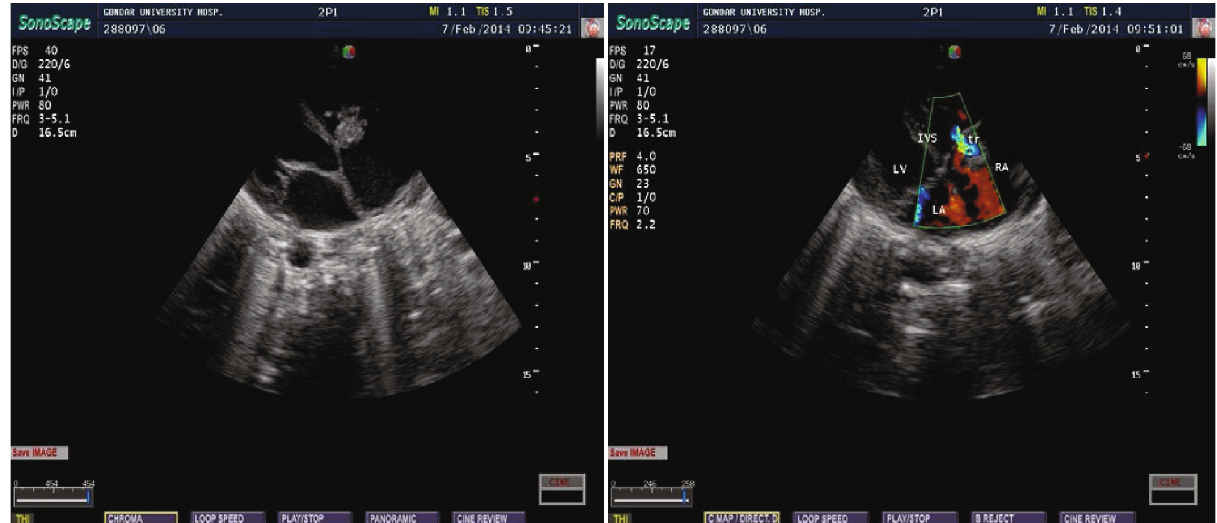
Figure 2: Doppler echocardiography showing an echogenic mobile focus (2.4cm by 1.7cm) attached to the anterior cusp of the valve (a) with moderate tricuspid regurgitation